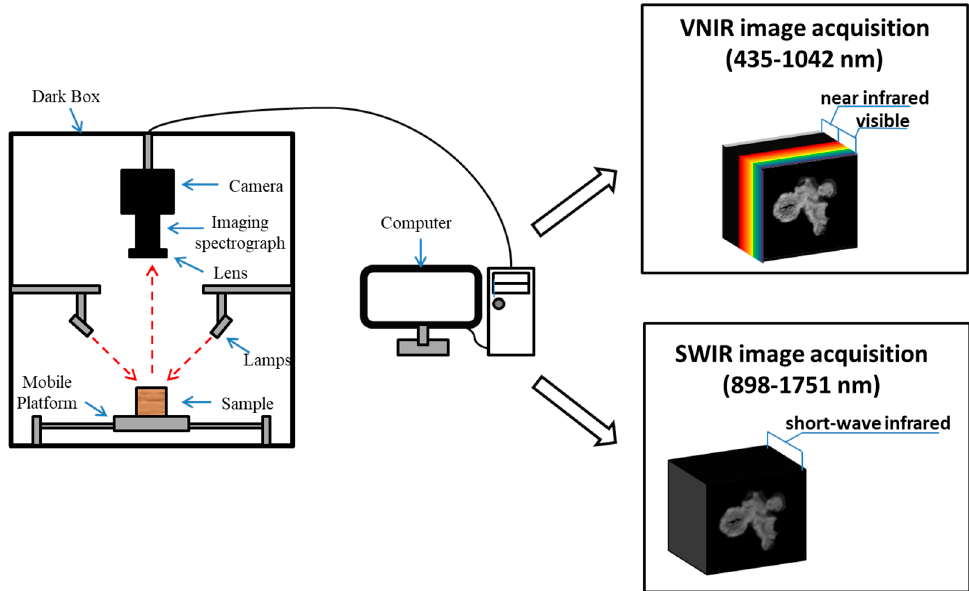
Figure 1. The hyperspectral imaging (HSI) system in reflection mode (VNIR: the visible and short-wave near-infrared, SWIR: long-wave near-infrared).